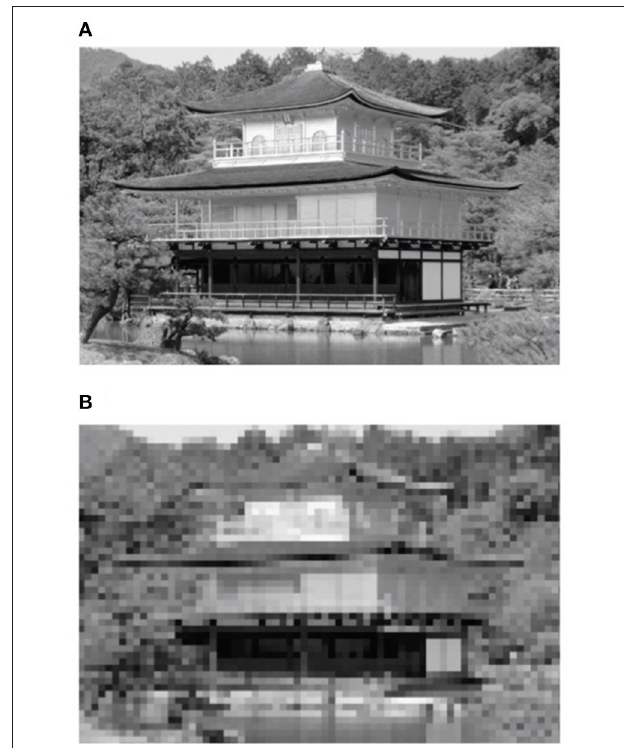
FIGURE 1 | Original ( A ; taken by Feng Li) and mosaic image (B) of the Kinkakuji, Kyoto,